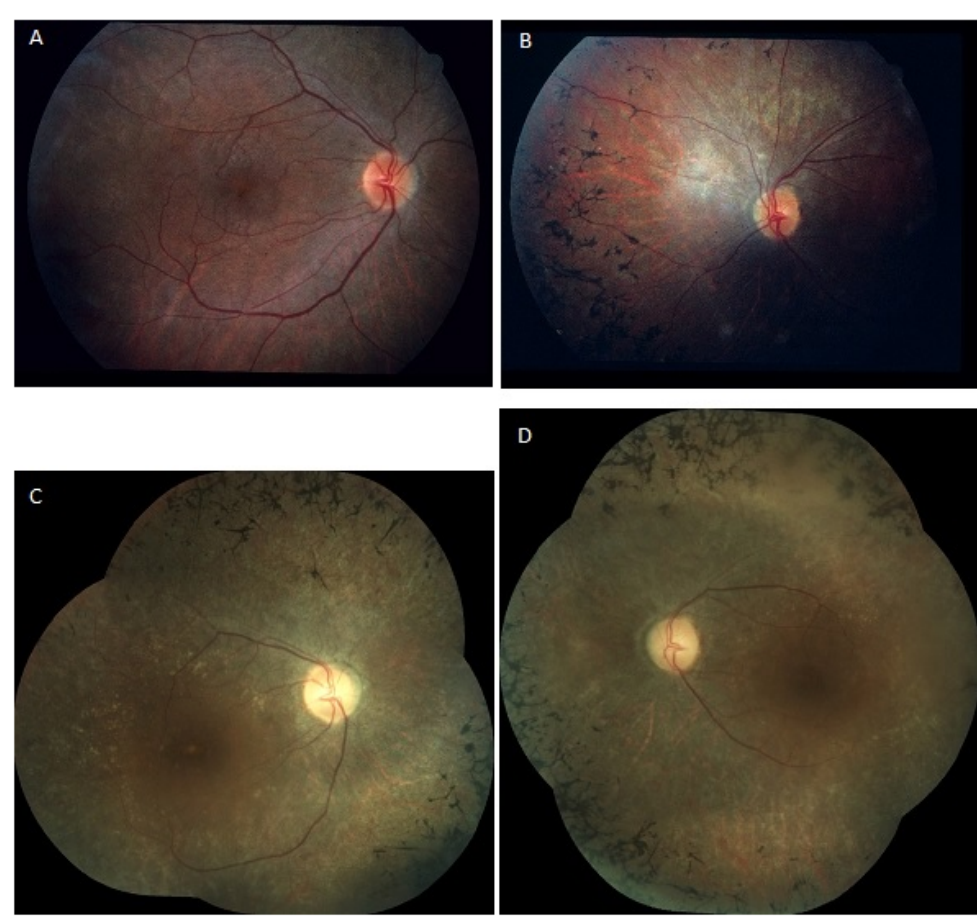
Figure 2: Fundus appearance in twin sisters with PMM2-CDG at the age of 18 and 41 years. (A,B) At the age of 18 years, a pink aspect of the optic discs and a moderate narrowing of the vasculature could be seen in addition to bony spicule pigmentary deposits in the mid peripheral retina, both in patient 1 (A) and patient 2 (B). In patient 1, a wrinkling of the macular retinal surface was noticed (A). (C,D) At the age of 41 years, findings of fundoscopy had remained the same for patient 1 (C) and patient 2 (D).